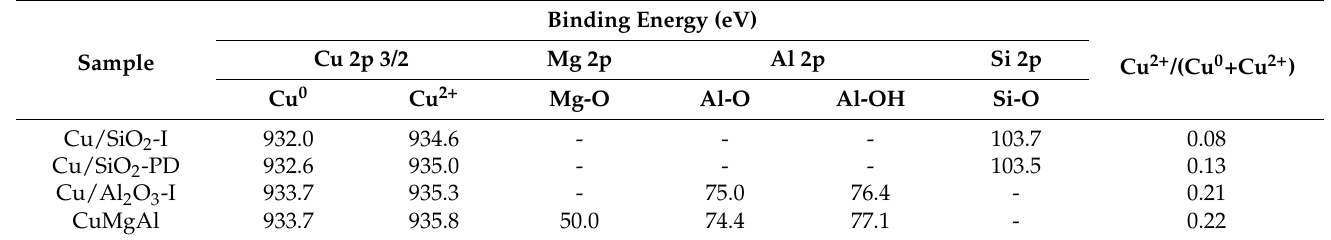
Table 2. Main XPS spectral lines of the reduced samples and relative surface concentrations of Cu 2+